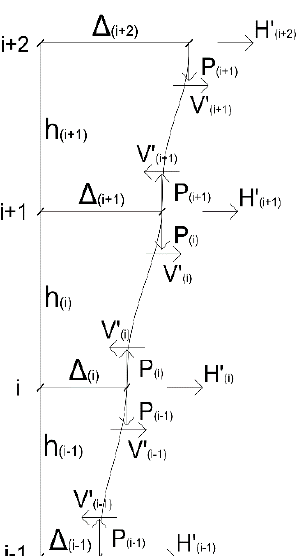
Figure 3 – Displacements and fictitious loads in multi-story buildings. Source: Adapted from NBR 8800:1986 [12].